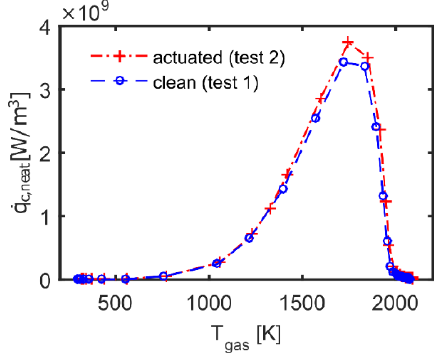
Figure 11. Numerical prediction of the flame speed as a function of the local equivalence ratio Φ .